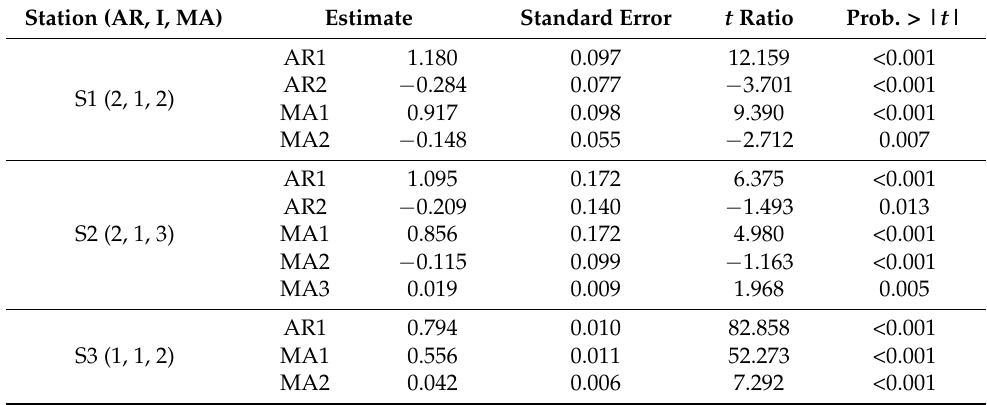
Table 4. Parameter estimates for the ARIMA model terms selected for daily PM 10 concentrations (DPM 10